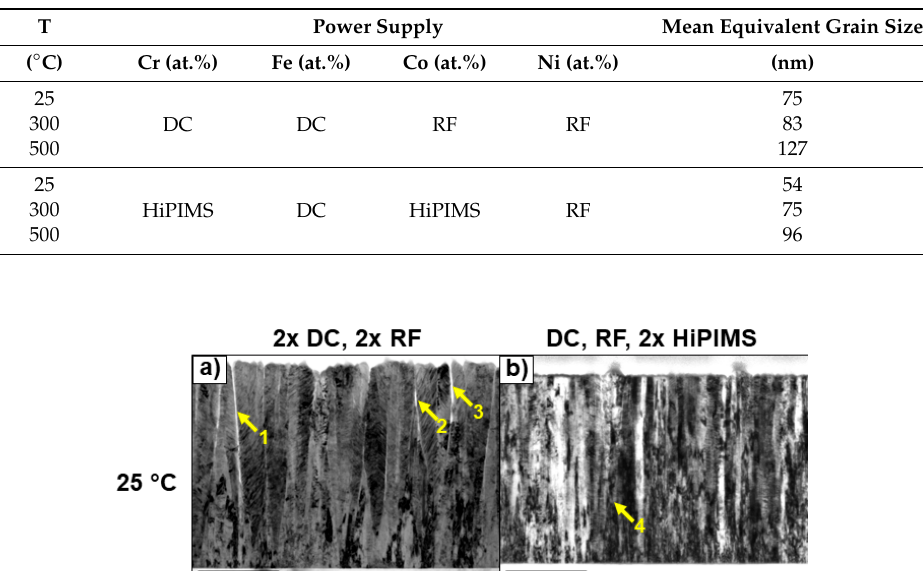
Table 5. Mean equivalent grain size calculated from the image-processed SEM micrographs.